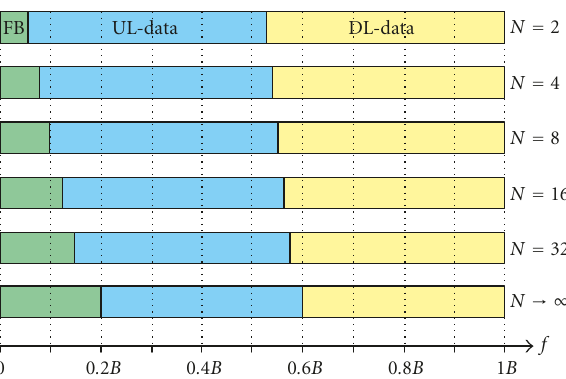
Figure 2: Optimum partitioning of the available bandwidth for a symmetric ( μ = 1) system operating at average SNR of 6dB with a bandwidth-time product of BT =